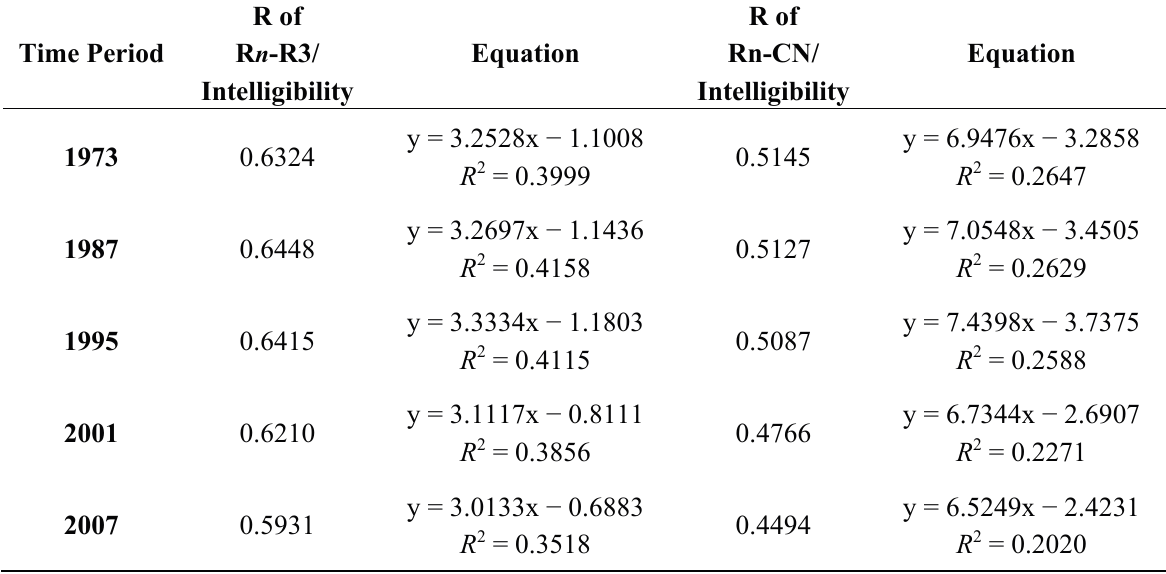
Table 5. Correlation values of global and local measures of ward 19 (where R = correlation, R n = global integration, R3 = local integration, and R 2 = tangent of